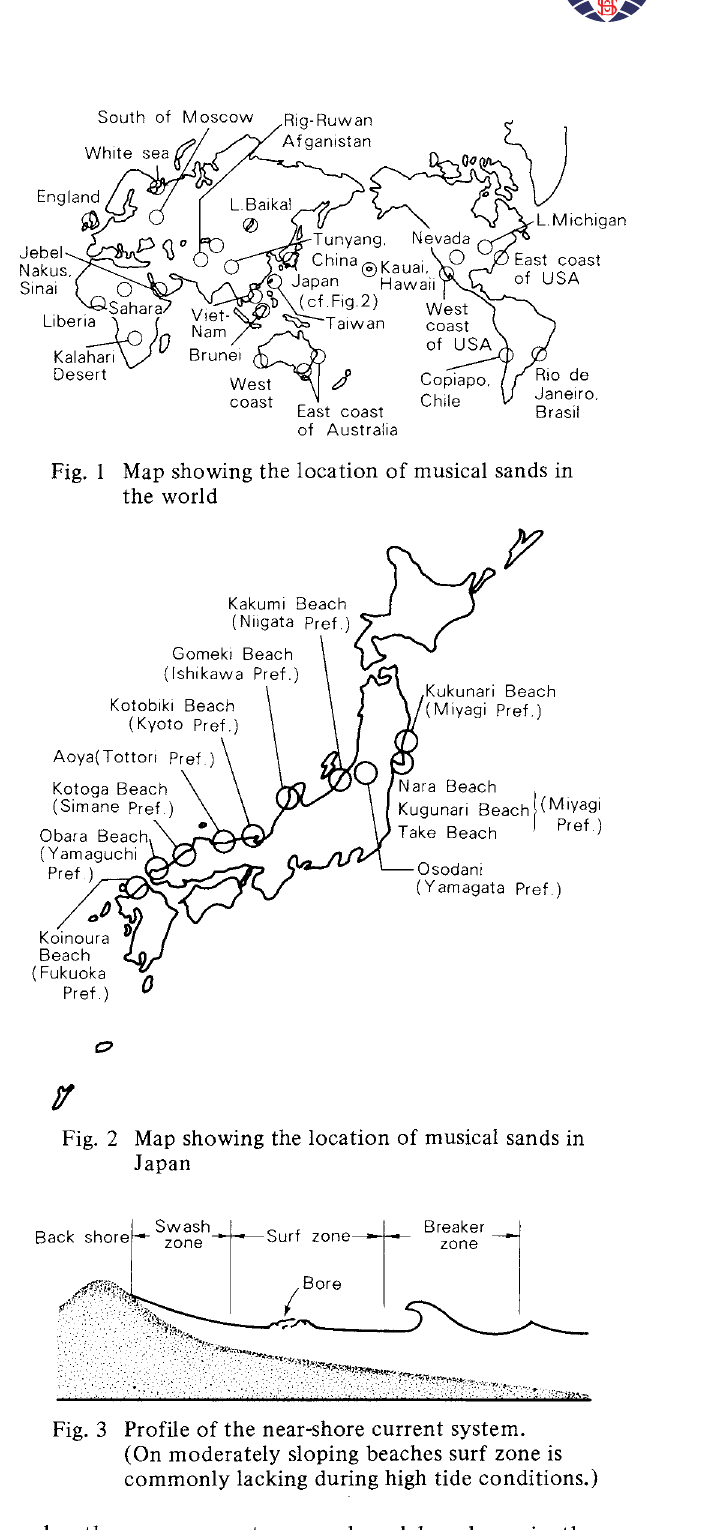
Fig. 3 Profile of the near-shore current system. (On moderately sloping beaches surf zone is commonly lacking during high tide